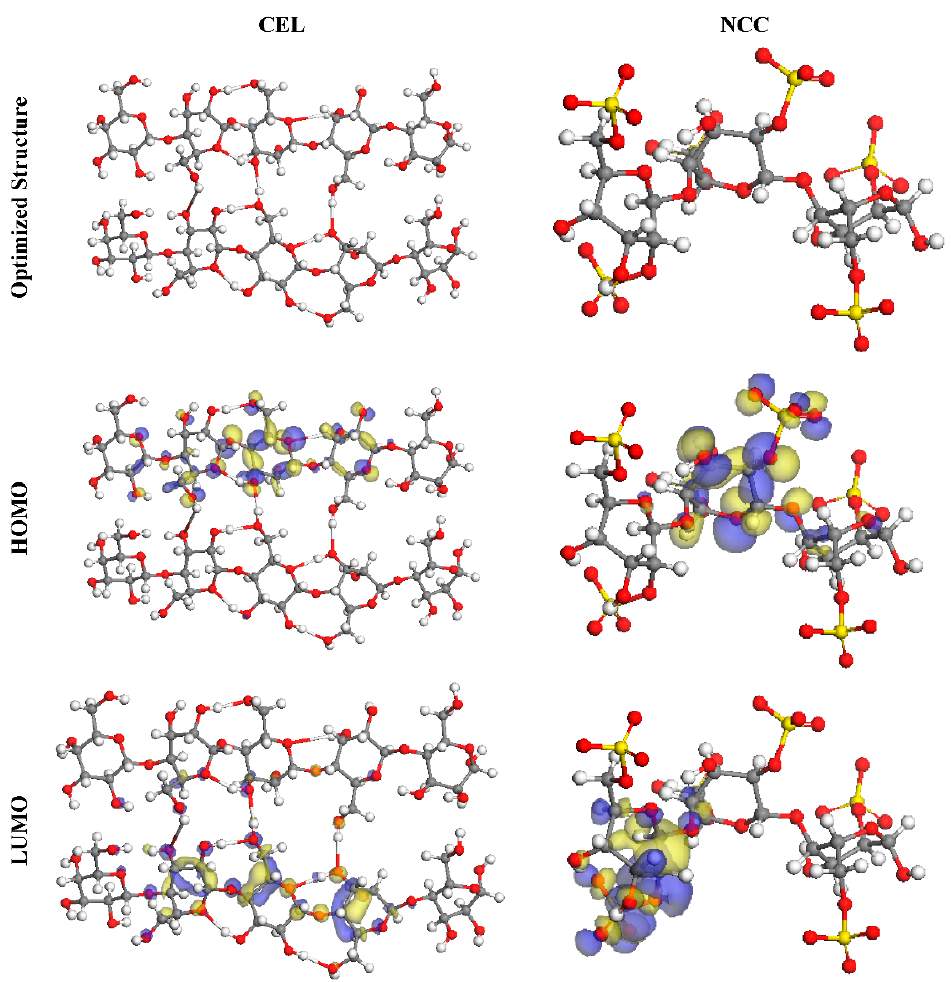
Figure 10. The optimized molecular configurations, HOMO, and LUMO of both inhibitors using DMol 3 array. Reprinted with permission from Ref. [8]. MDPI